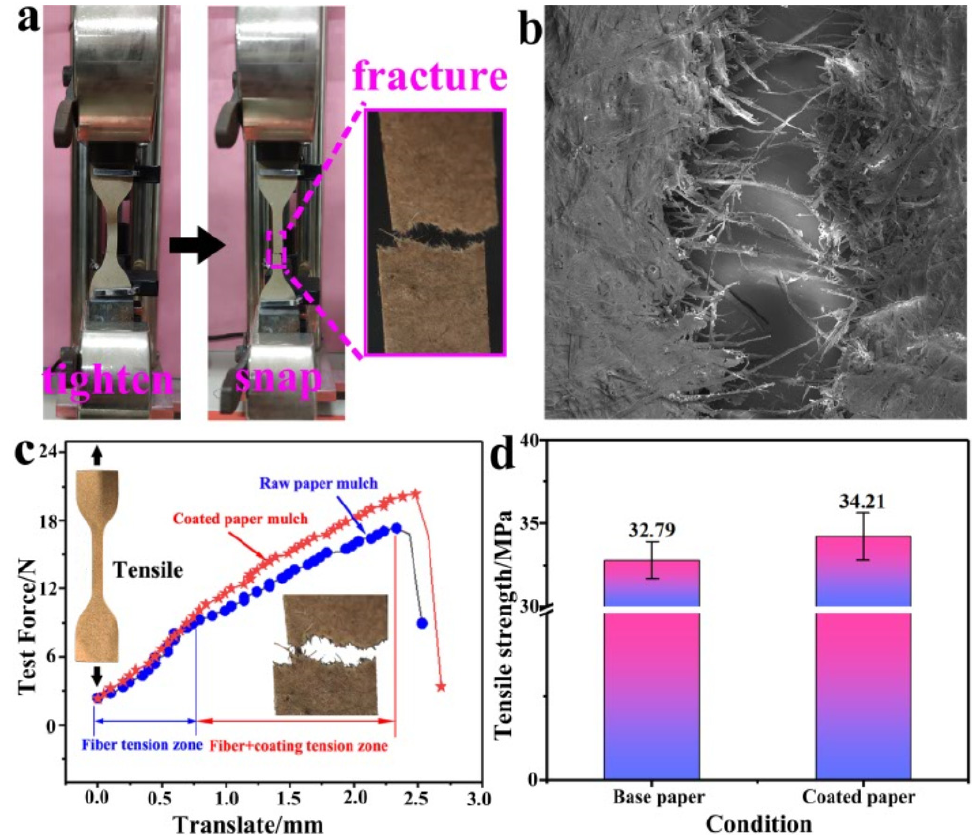
Figure 10. ( a ) Tensile graph, ( b ) Tensile process graph, ( c ) Tensile strength graph, ( d ) Tensile fracture electron microscope graph.